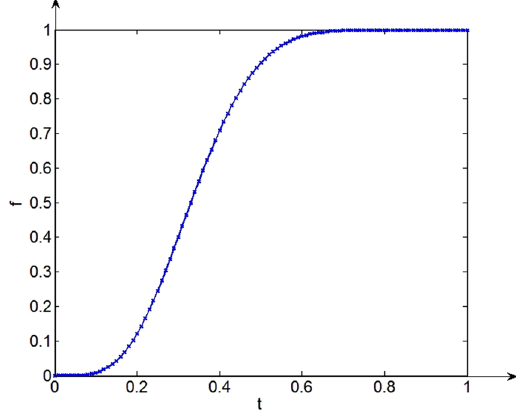
Figure 5. Transformation function curve.